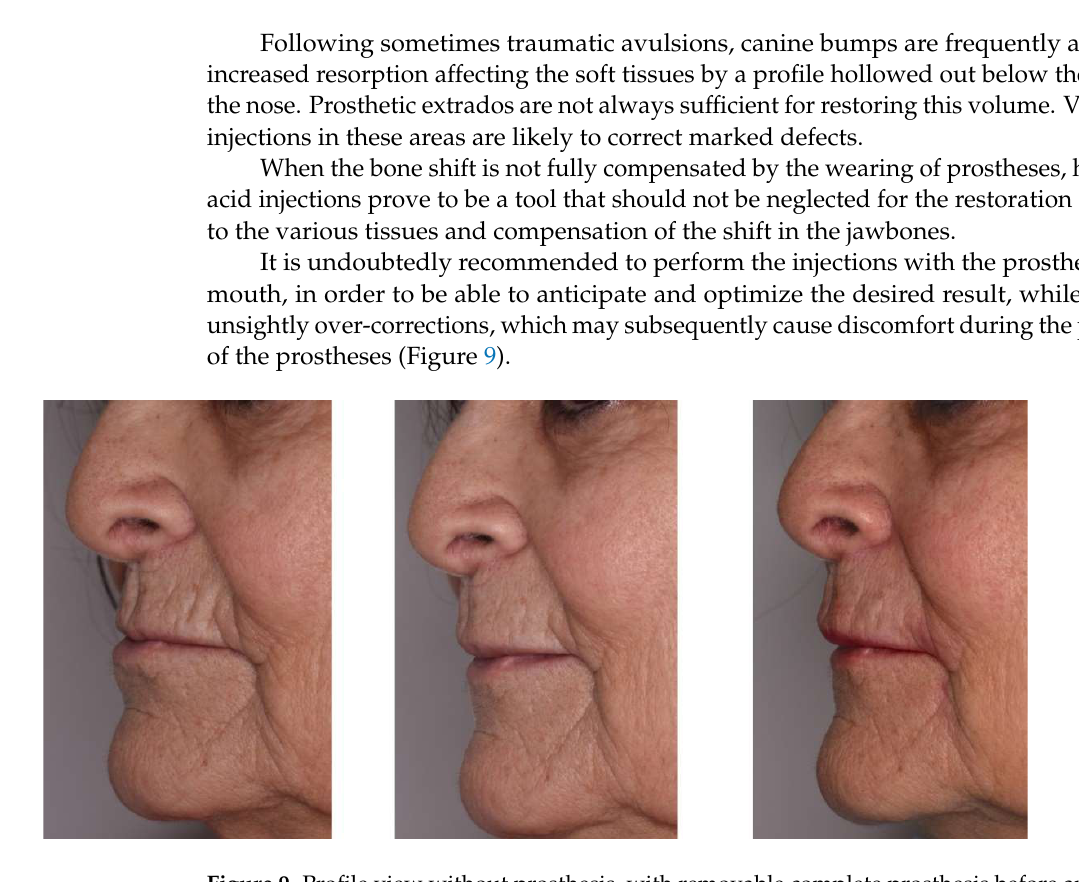
Figure 9. Profile view without prosthesis, with removable complete prosthesis before and immedi- ately after hyaluronic acid injection.